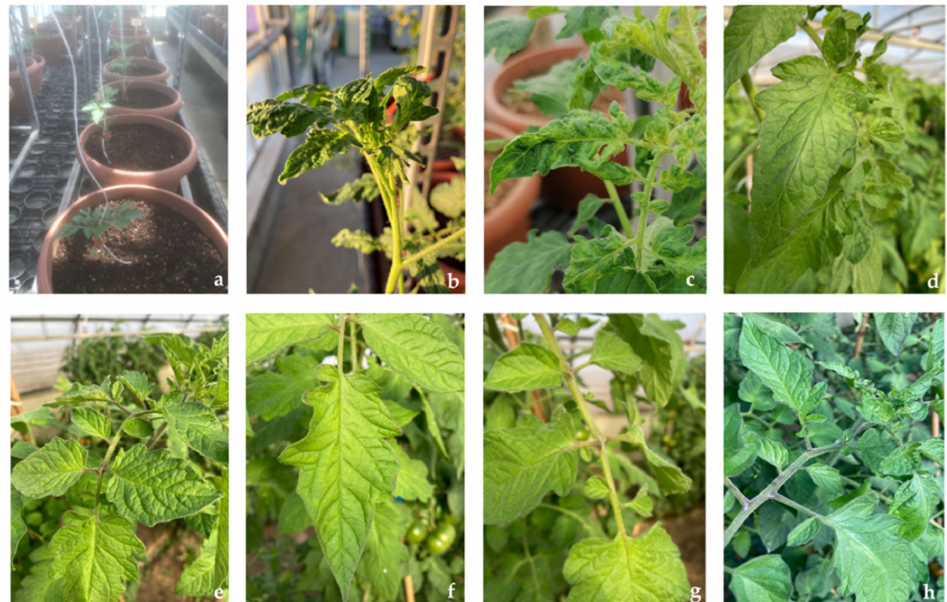
Figure 3. Plant inoculation test. ( a ): trial’s layout. ( b – h ): 35 days after the inoculation. ( b , c ): symp- tomatic apical leaves (plants inoculated with Positive Control); ( d ): not symptomatic apical leaves (plants inoculated with Negative Control); ( e ): not symptomatic apical leaves (plants inoculated with inoculum treated with 1 ); ( f ): not symptomatic apical leaves (plants inoculated with inoculum treated with AME); ( g ): not symptomatic apical leaves (plants inoculated with inoculum treated with 2 ); ( h ): not symptomatic apical leaves (plants inoculated with inoculum treated with